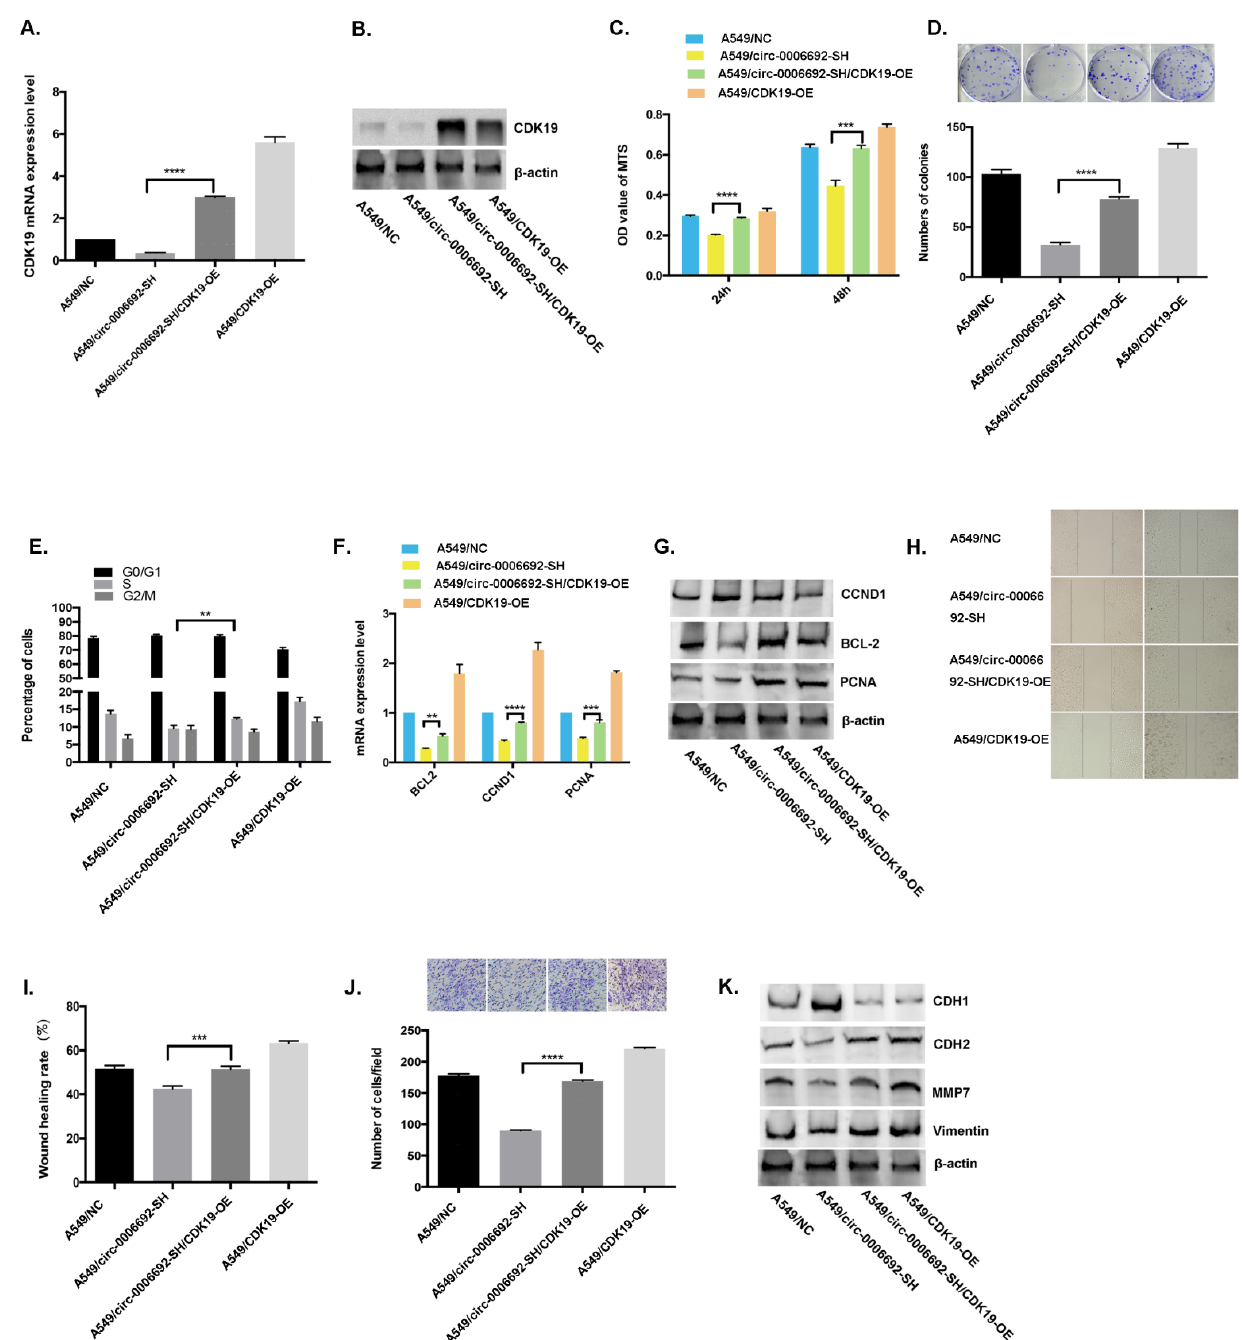
Figure 6. Enhancement of CDK19 was critical for circ-0006692-mediated malignant behaviors. ( A , B ) CDK19 expression in A549 cells in the rescue assay via RT-PCR and WB. ( C , D ) MTS assay and colony formation of A549 cells. ( H , I ) Wound healing assay of A549 cells; ( J ) Transwell invasive assay of A549 cells; ( F , G ) The expression levels of proliferation-associated-genes of BCL-2 , CCND1 , and PCNA measured by qRT-PCR and WB; ( K ) The expressions of EMT-associated-genes MMP7 , VIMENTIN , CDH1 , and CDH2 demonstrated by Western blotting; ( E ) Cell cycle distribution of A549 cells by FACS; ** p < 0.01; *** p < 0.001, **** p < 0.0001. 3.6. Hsa_circ_0006692 Facilitated the Progress of Lung Cancer in Zebrafish To identify the biofunction of hsa_circ_0006692 in vivo, the zebrafish model was used. The results (Figure 7A,B) of the in vivo zebrafish assay with a stereomicroscope and